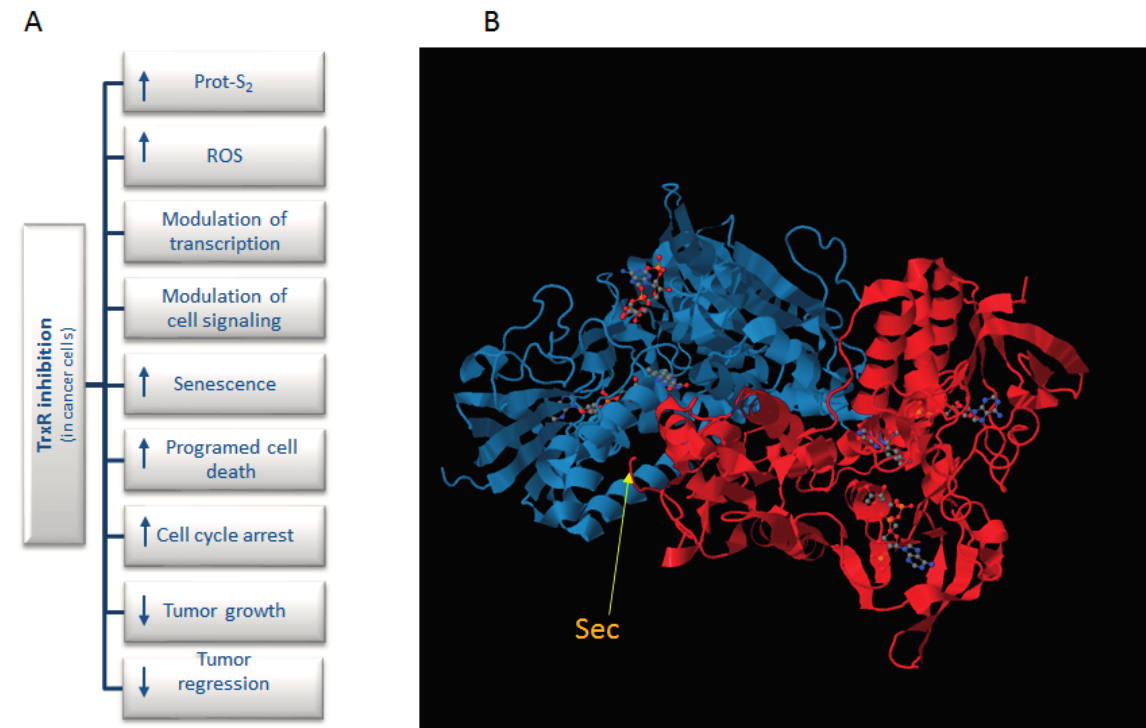
Figure 1. ( A ) Schematic summary of the various effects caused by TrxR inhibitors; ( B ) X-ray structure of mammalian TrxR (PDB;